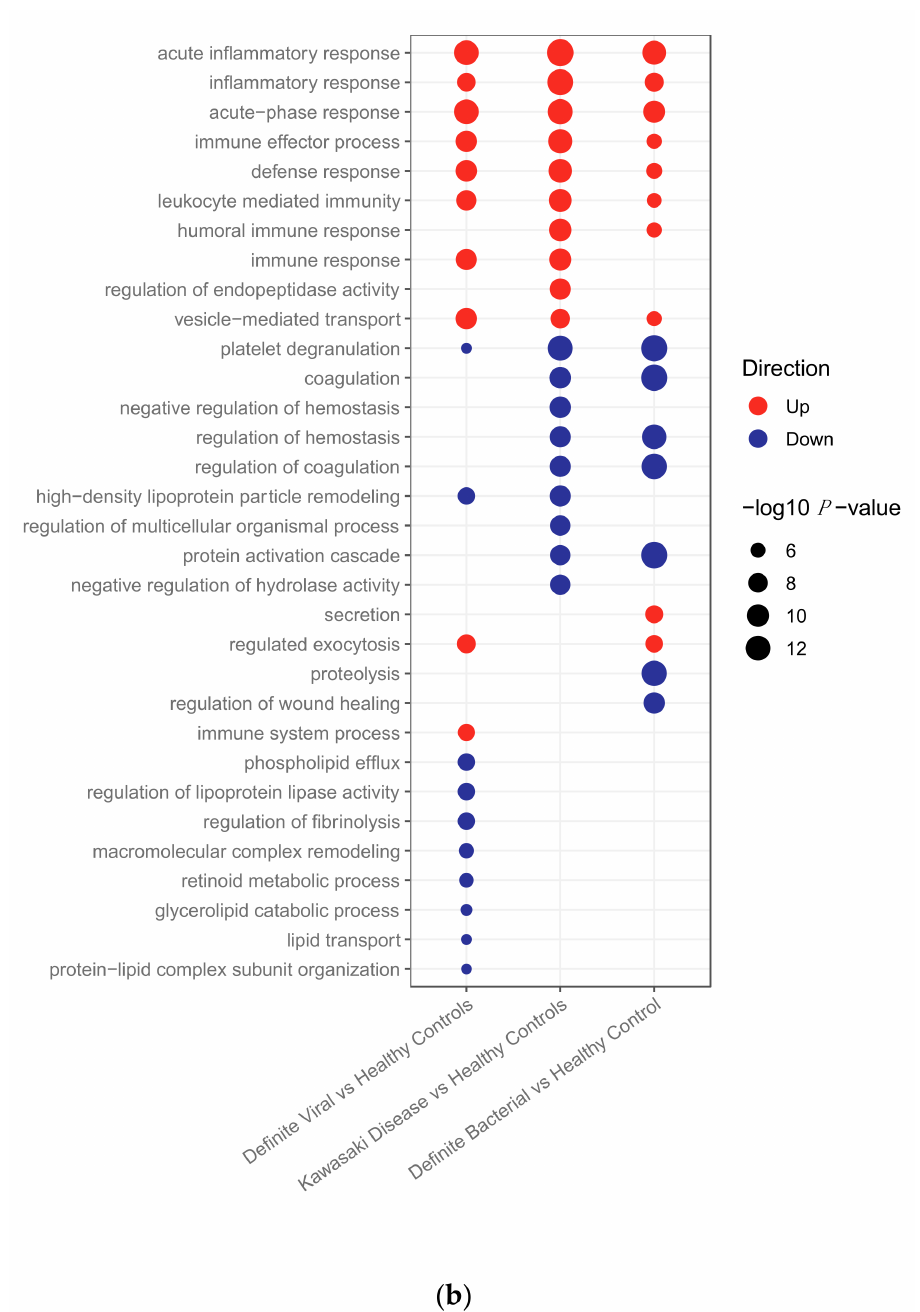
Figure 1. ( a ) Pathways upregulated and downregulated in bacterial, Kawasaki Disease and viral patients compared to healthy controls in the transcriptomic dataset. ( b ) Pathways upregulated and downregulated in bacterial, Kawasaki Disease and viral patients compared to healthy controls in the proteomic